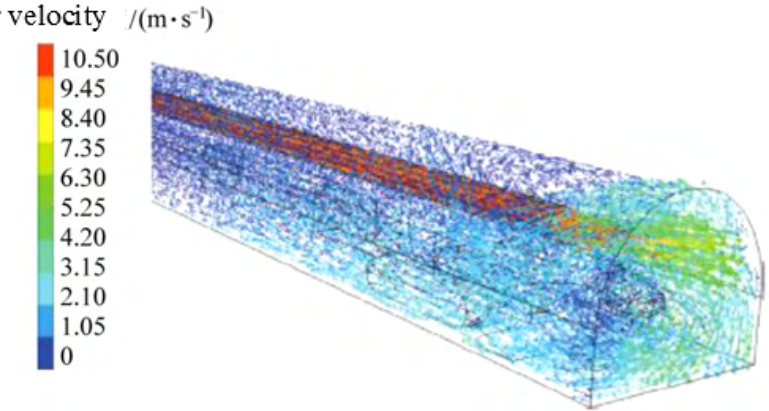
Figure 5. Distribution of flow field in forced ventilation [51].